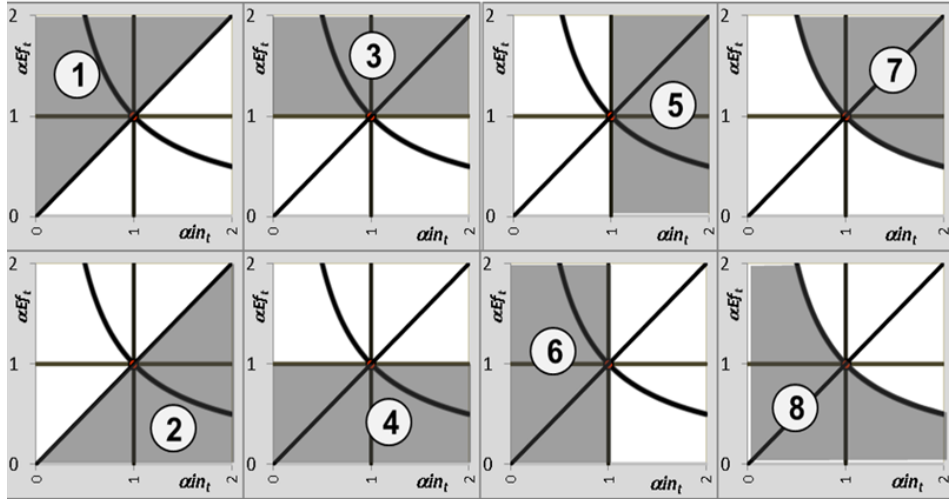
Figure 4. Zones with possible system